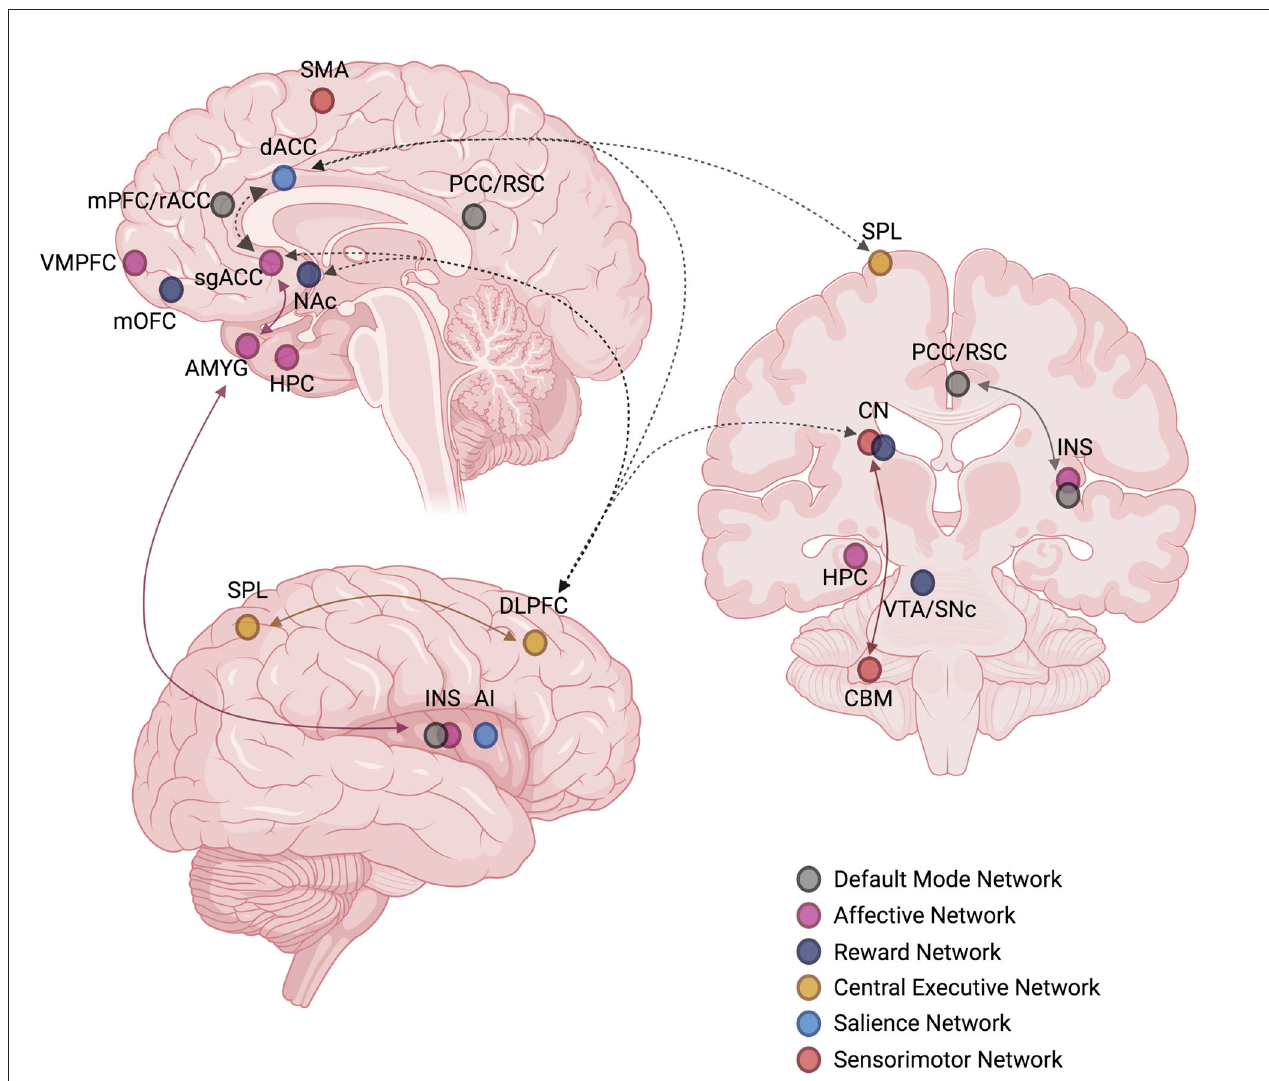
FIGURE 5 | Commonly reproduced intrinsic connectivity network (ICN) nodes and edges targeted by ketamine or implicated in predicting rapid antidepressant treatment response to ketamine. Solid colored arrows indicate within-network connectivity, dashed black arrows indicate between-network connectivity. The laterality of nodes and edges is not considered. Created with BioRender.com, RRID:SCR_018361. AI, anterior insula; AMYG, amygdala; CBM, cerebellum; CN, caudate nucleus; dACC, dorsal anterior cingulate cortex; DLPFC, dorsolateral prefrontal cortex; HPC, hippocampus; INS, insula; mOFC, medial orbitofrontal cortex; mPFC, medial prefrontal cortex; NAc, nucleus accumbens; PCC, posterior cingulate cortex; rACC, rostral anterior cingulate cortex; RSC, retrosplenial cortex; sgACC, subgenual anterior cingulate cortex; SMA, supplementary motor area; SNc, substantia nigra pars compacta; SPL, superior parietal lobule; VMPFC, ventromedial prefrontal cortex; VTA, ventral tegmental